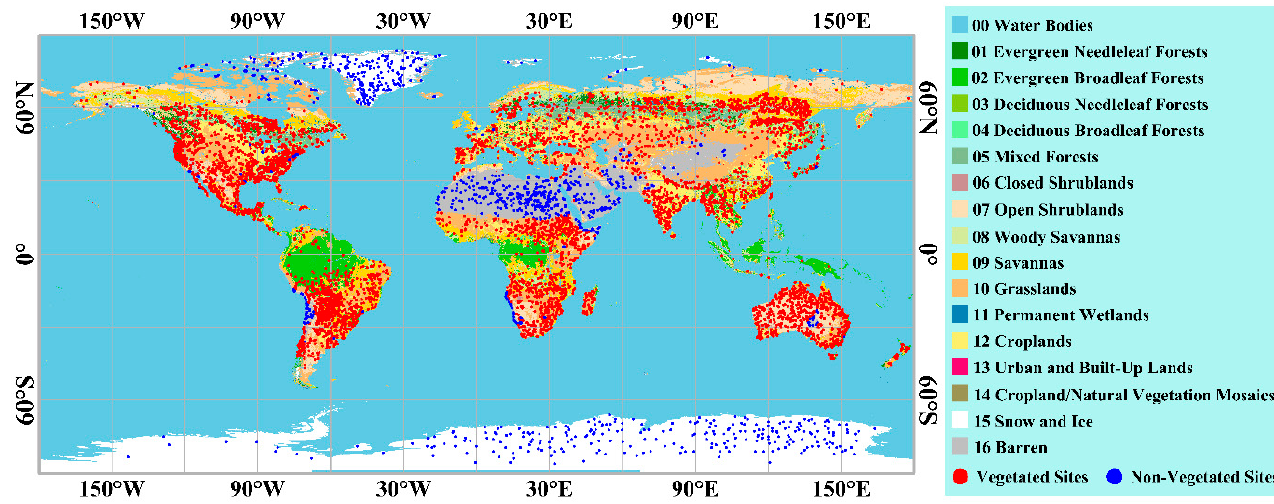
Figure 1. Global distribution of the selected POLDER BRDF database sites over the MODIS IGBP land cover map. The red and blue points represent the data in vegetated and non-vegetated lands, respectively.